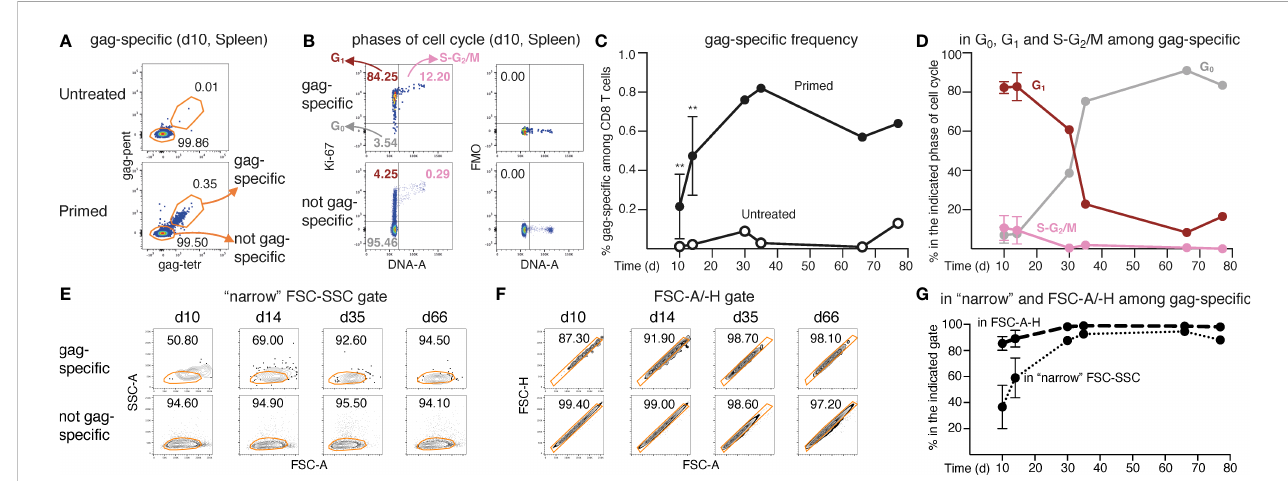
FIGURE 1 Analysis of frequency and cell cycle of gag-speci fi c CD8 T cells from ChAd-gag-primed mice. Female BALB/c mice were primed i.m. in the quadriceps with ChAd-gag (10 7 vp) at d0 and the kinetics of gag-speci fi c CD8 T cell response was tracked by fl ow cytometry. (A – G) . Spleen cells were analysed by membrane and Ki-67/DNA staining at different days (d) post-prime (gating strategy in Figure S1A). Typical plots showing the percentage of “ gag-speci fi c ” and “ not gag-speci fi c cells ” from untreated (top) and primed (bottom) mice at d10 (A) . gag-speci fi c cells from primed mice were further analyzed on DNA/Ki-67 plots as follows ( B , top left panel): cells in the G0 phase of cell cycle were identi fi ed as DNA 2n/ Ki-67 — (bottom left quadrant); cells in G1 as DNA 2n/ Ki-67 + (upper left quadrant); cells in S-G2/M as DNA>2n/ Ki-67 + (top right quadrant). As a comparison, not gag-speci fi c cells ( B , bottom left panel) are shown. For each DNA/Ki-67 plot, corresponding Ki-67 Fluorescence Minus One (FMO) control plots ( B , right panels) are shown. Summary of the kinetics of gag-speci fi c frequency in primed and untreated mice (C) , and of cell cycle phases of gag-speci fi c CD8 T cells in primed mice (D) (summary of cell cycle phases of not gag-speci fi c CD8 T cells shown in Figure S1B). Kinetics of the percentages of gag-speci fi c and not gag-speci fi c CD8 T cells in the “ narrow ” FSC-SSC gate (examples in E ) and in the FSC-A/-H gate (examples in F ), and summary of gag-speci fi c CD8 T cell results (G) (summary of not gag-speci fi c CD8 T cell results shown in Figure S1E). The fi gure summarizes results of 6 independent prime experiments with a total of 84 mice analyzed at the indicated d post-prime. In fl ow cytometry plots (in A, B, E, F ), numbers represent percentages of cells in the indicated regions. In panels (C, D, G) , symbols at d10 and d14 represent the mean and bars the Standard Deviations of 5 experiments (each performed with pooled cells from 3 mice per group). At d30, d35, d66 and d77, each symbol represents a pool of 3 mice. Statistical analysis was performed using Mann-Whitney test for comparison between untreated and primed mice at d10 and d14 (C) , and Wilcoxon test for comparison between gag-speci fi c CD8 T cells in the “ narrow ” FSC-SSC gate and in the FSC-A/-H gate at d10 and d14 (G) . Statistically signi fi cant differences are indicated (** P ≤ 0.01). This fi gure includes unpublished data in relation to